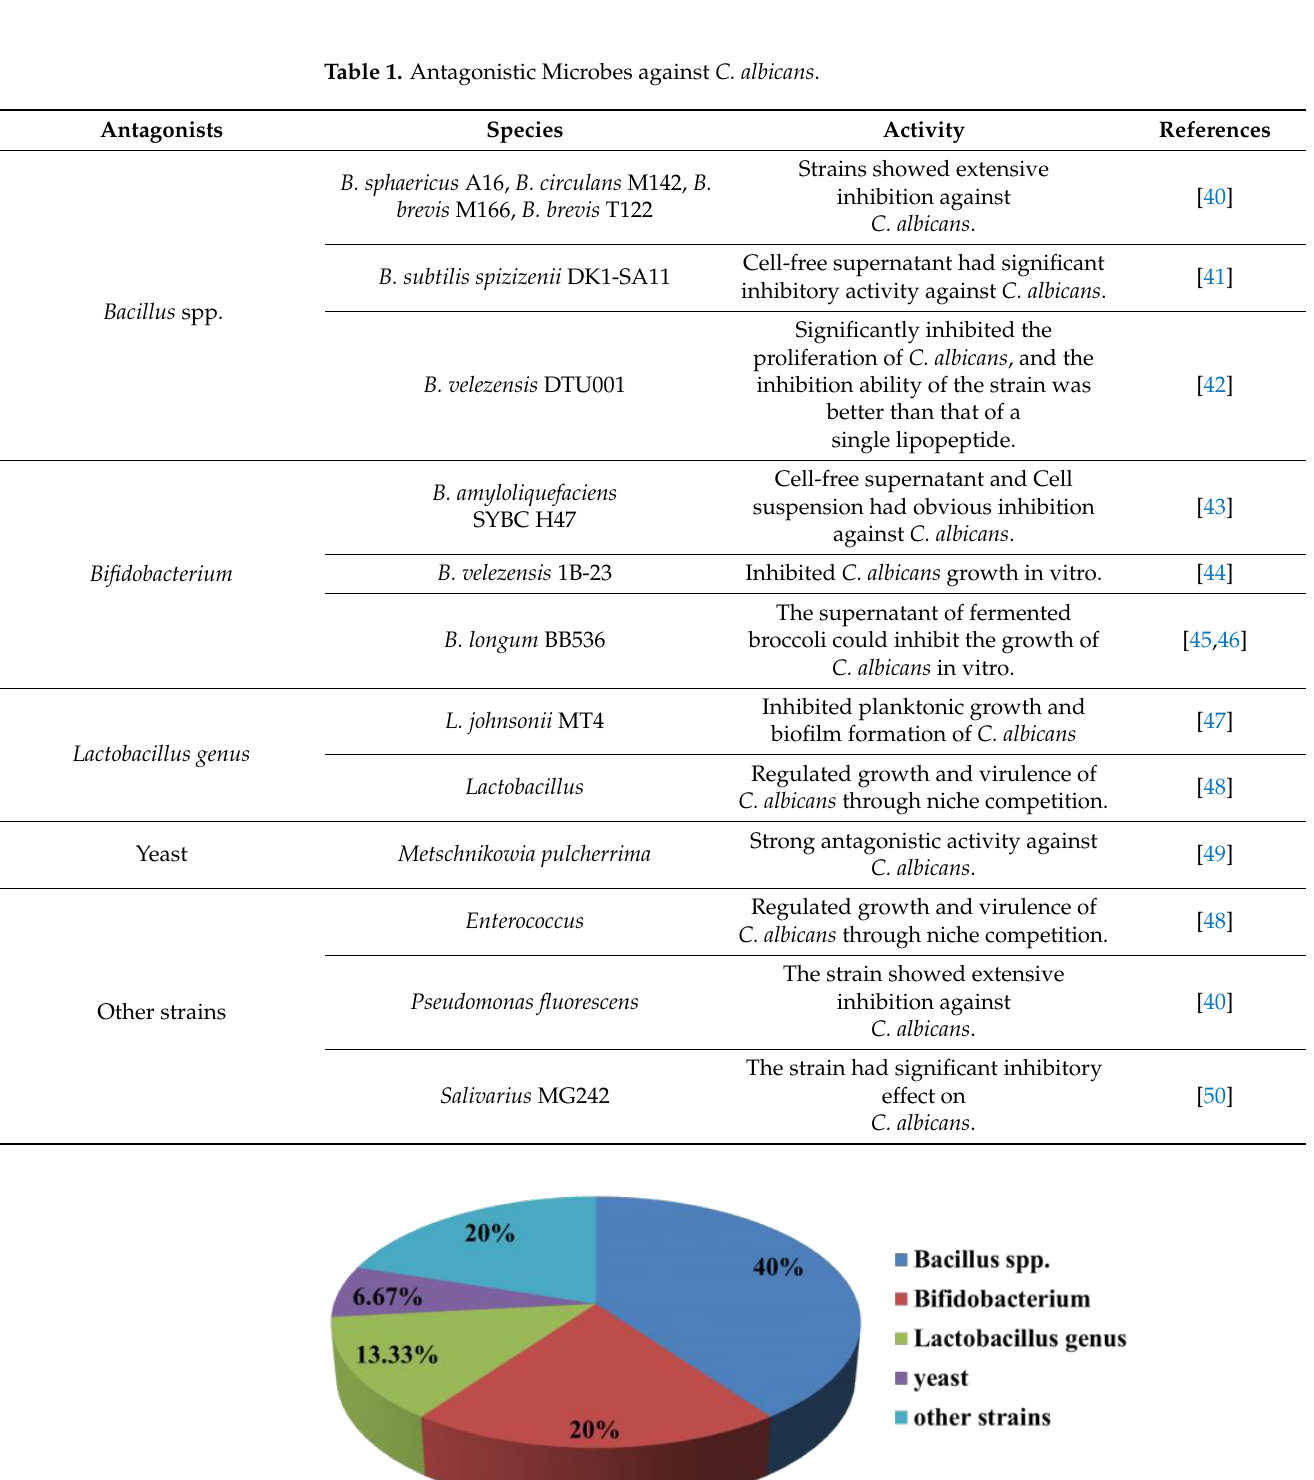
Figure 1. Percentages of different antagonistic microbes of C. albicans.